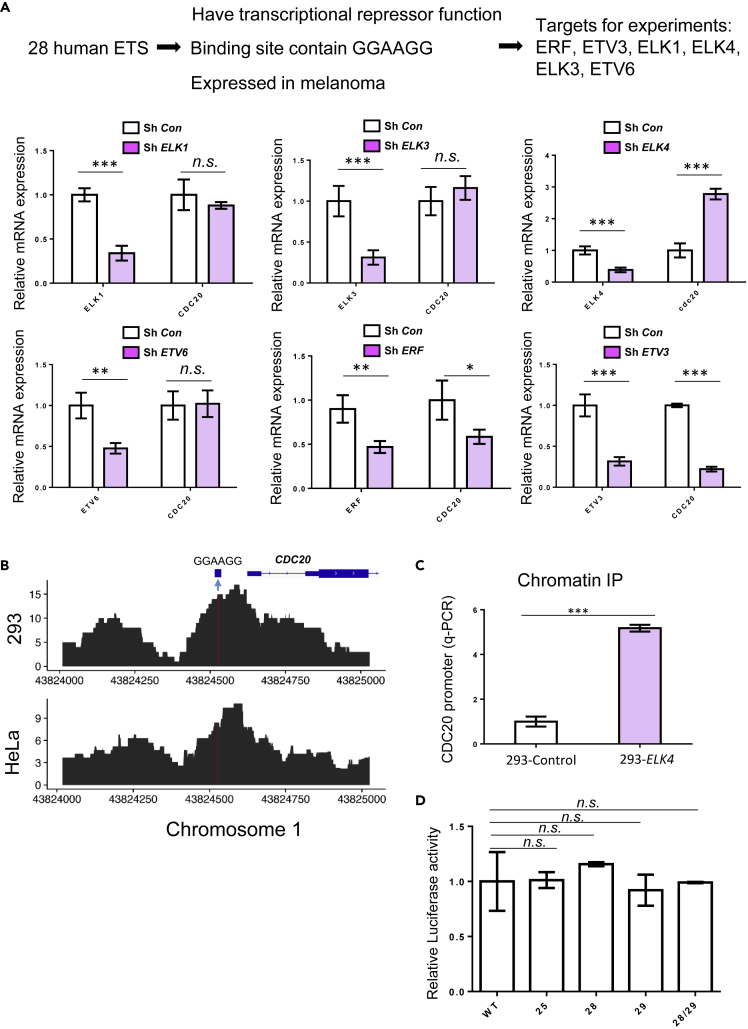
ELK4 binds to the hotspot mutation targeted sequence and represses CDC20 transcription(A) Screen for ETS proteins that bind the hotspot mutation targeted sequence “GGAAGG” and repress CDC20 transcription. shRNA experiments were performed in 293 cells; expression of each ETS and CDC20 mRNA was quantified by qPCR. ∗p < 0.05, ∗∗p < 0.01, ∗∗∗p < 0.001, Student's t test compared to sh-control. The results are an average of three independent experiments. Values are mean ± SD.(B) ENCODE ELK4 ChIP-seq data around the hotspot mutation target sequence “GGAAGG” in 293 and HeLa cells.(C) ChIP was performed with anti-FLAG antibody in M14 cells stably expressing FLAG-ELK4 or FLAG control. The DNA sequence around the hotspot mutation target sequence was quantified with qPCR. ∗∗∗p < 0.001, Student's t test compared with FLAG control. The results are an average of three independent experiments. Values are mean ± SD.(D) Luciferase reporter assay was performed in ELK4 knockdown 293 cells with wild-type or mutant CDC20 promoter driving luciferase vectors. The results are an average of three independent experiments. Values are mean ± SD.